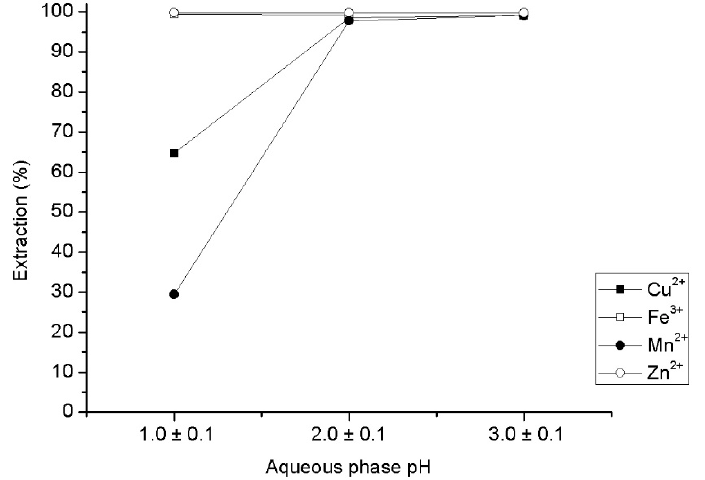
Figure 3. Effect of initial pH on the single extraction percentage of metals from aqueous solution. Experimental conditions: [R 4 NCy] = 0.54 M, O/A = 1, 400 min − 1 , and 20 min of stirring time.